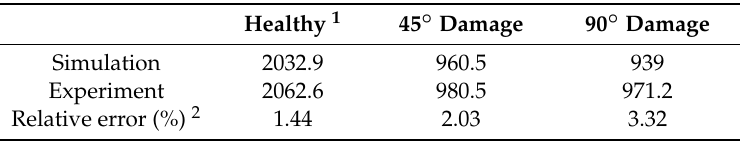
Table 8. Comparison of the damage localization